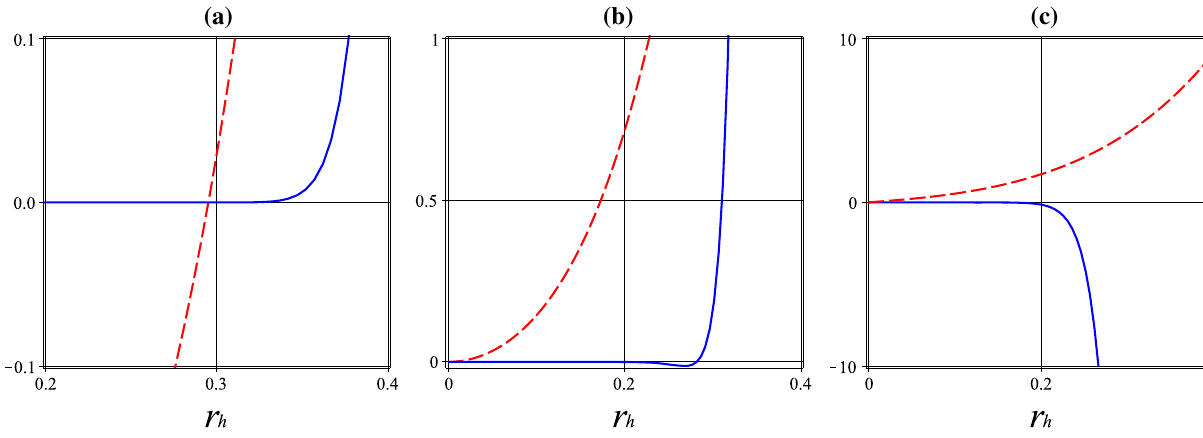
Fig. 2 Critical points of LMP solution in spherical space for l = 1 and a = 10: a α = γ = − 1. b α = γ = 0. c α = γ = 1. Dashed red lines , while solid blue lines represent d 2 P represent dP dV dV 2